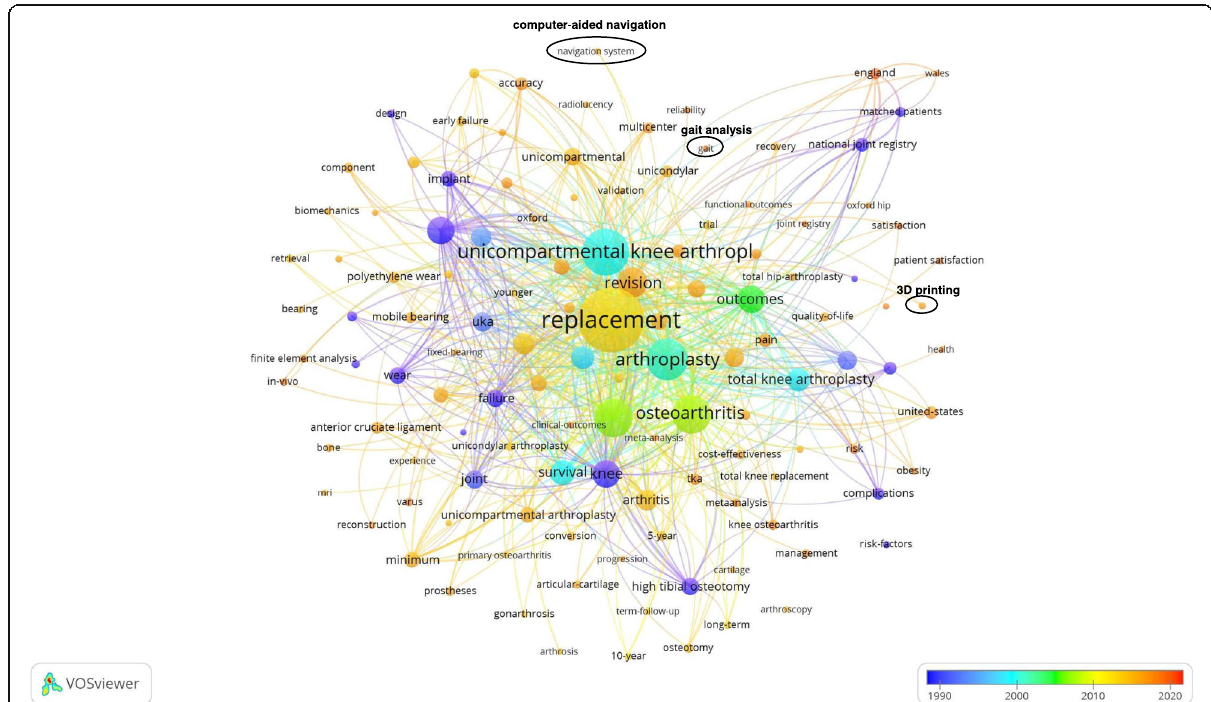
Fig. 6 Analysis of research hotspot trends. Over time, the colors in the picture show a purple-green-red change. Keywords in blue belong to early research hotspots, and red parts indicate future research